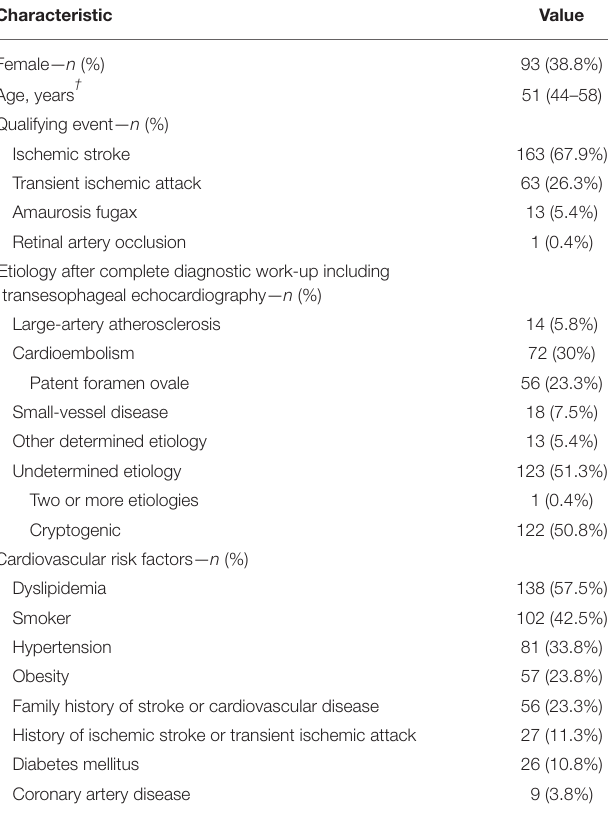
TABLE 1 | Baseline characteristics of the 240 study